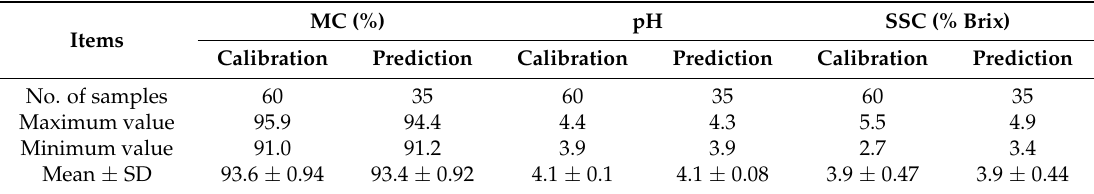
Table 1. Characteristics of calibration and prediction sample sets.